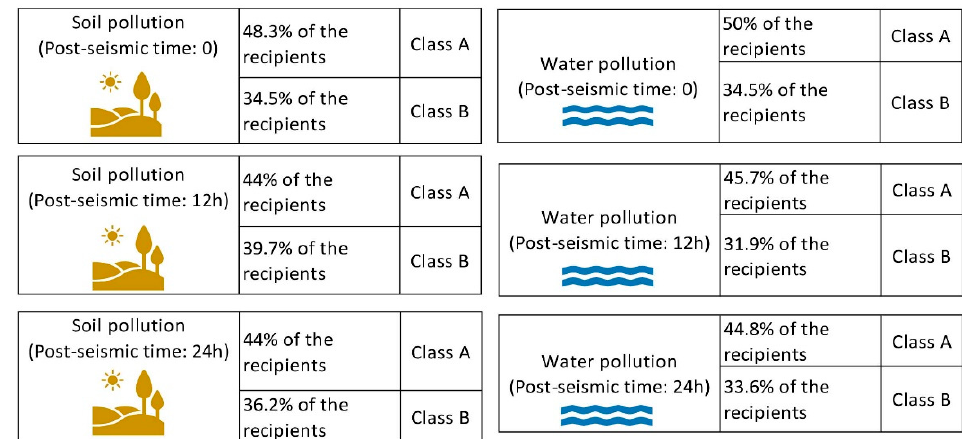
Table 3. Comparison between the seismic vulnerabilities of WWTPs.